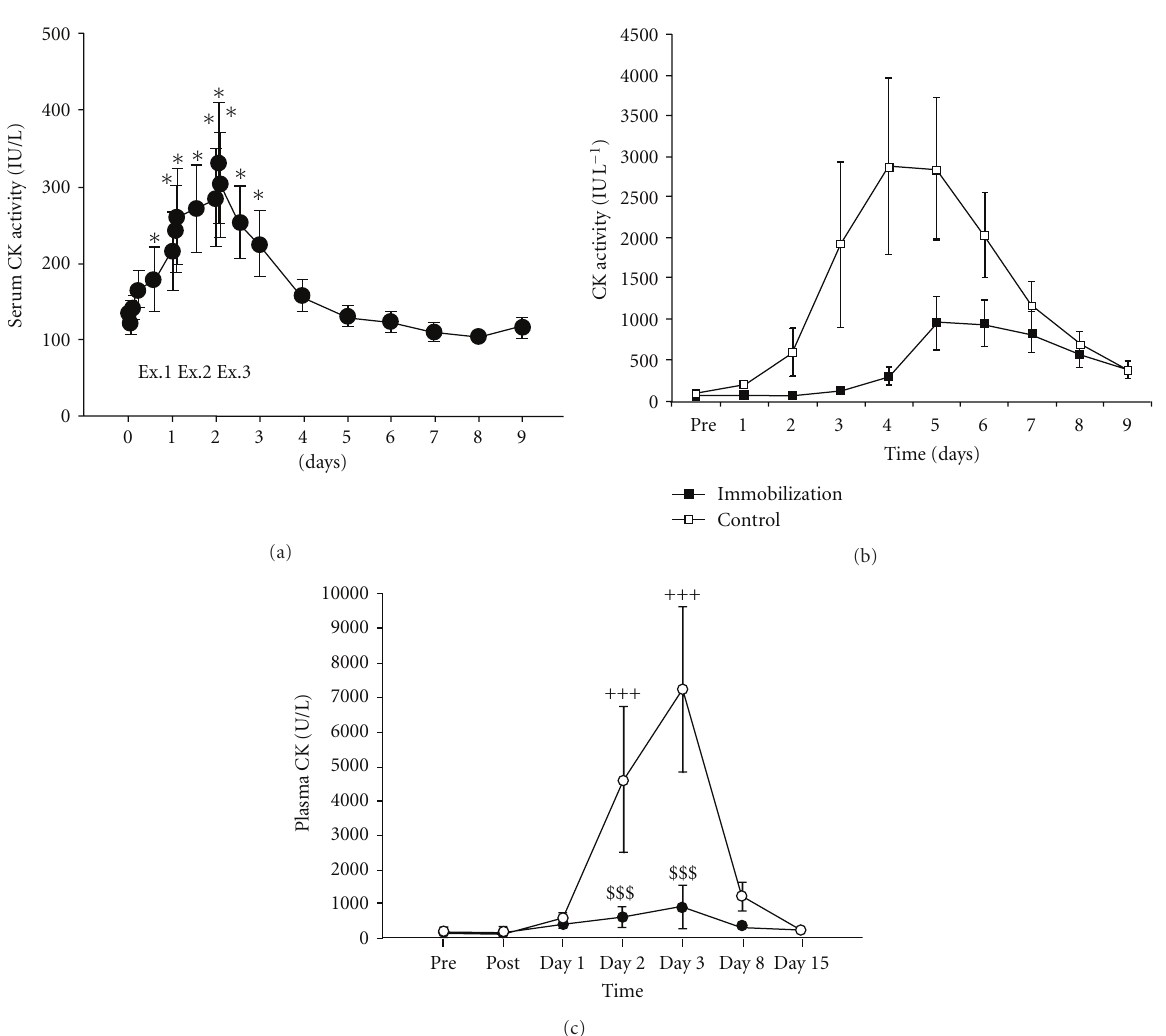
Figure 3: (a) Changes in serum creatine kinase (CK) activity during 90-minute cycling exercise on three consecutive days (Ex1, Ex2, and Ex3), reprinted from Totsuka et al. with permission from American Physiological Society [6]. (b) Creatine kinase (CK) response to eccentric exercise between immobilisation and control group. PRE refers to the baseline period before exercise. Days 1–4 represent the 4- day immobilization and days 5–9 are the recovery period. Reprinted from Sayers and Clarkson [4]. (c) Creatine kinase (CK) activity in women and in men before (pre), immediately after (post), and 15 days after step exercise. +++ Significant di ff erence from preexercise level ( P < 0 . 001). $$$ Significant di ff erence between men and women ( P < 0 . 001), reprinted from Fredsted et al.